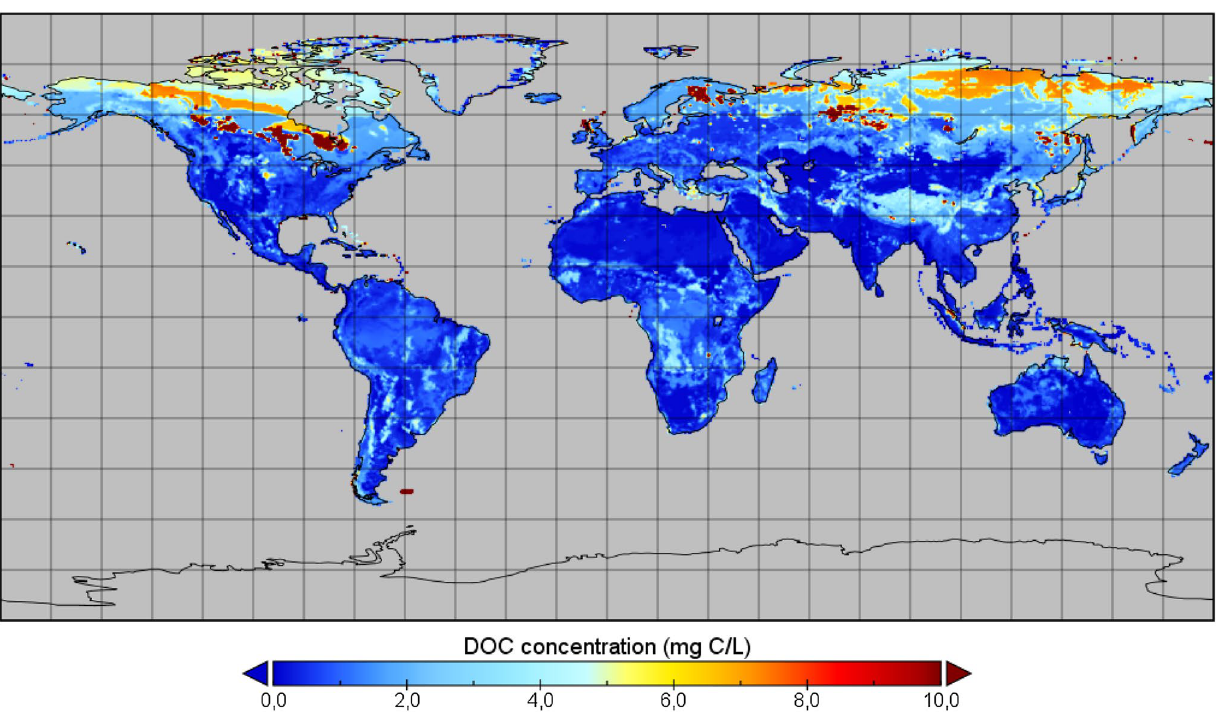
Fig. 11 Modelled global subsoil DOC concentrations in soil solutions (mg C L −1 ) at a depth of one meter. Based on equation 2 using topsoil data from Fig.